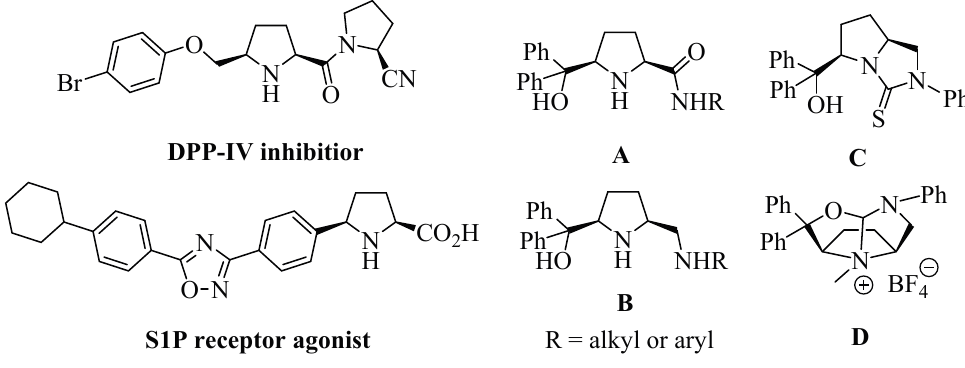
Figure 1. Some novel unsymmetrical cis -2,5-disubstituted